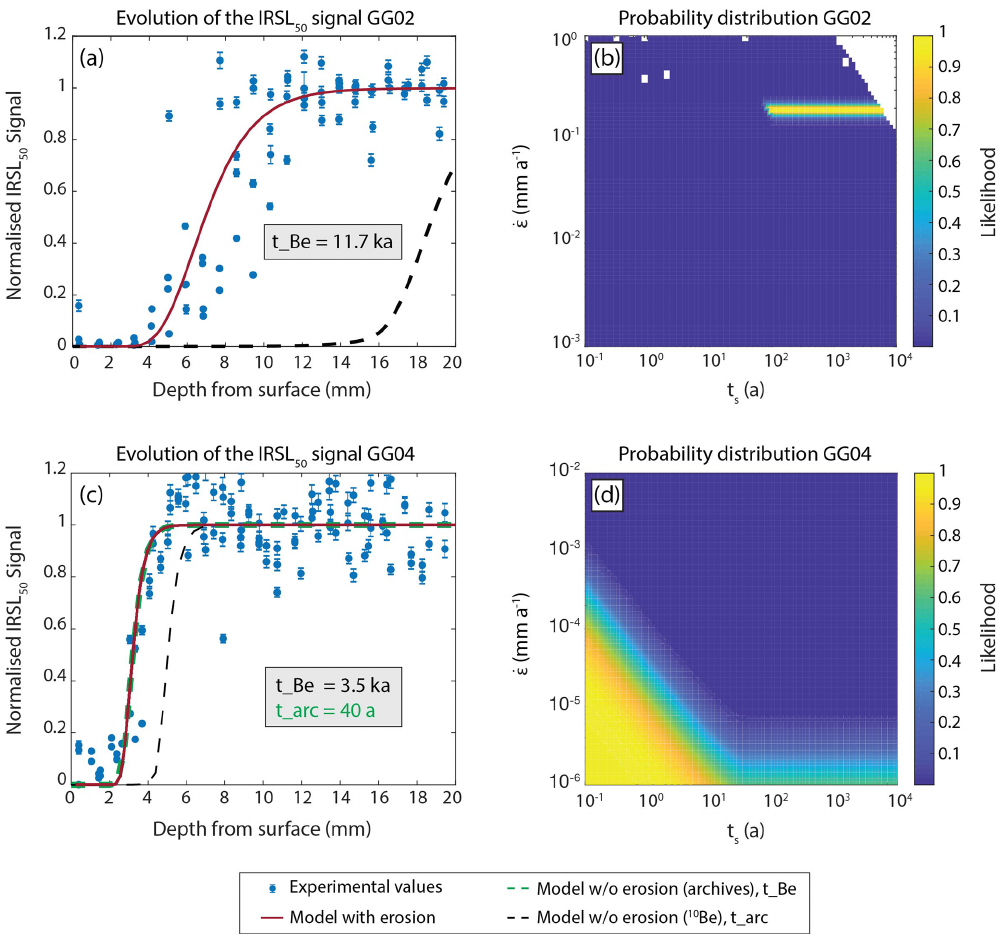
Figure 4. IRSL 50 luminescence–depth profiles and probability distribution inversion results for samples GG02 (a, b) and GG04 (c, d) . For the luminescence profiles (a, c) , the blue dots represent IRSL 50 luminescence measurements at that particular depth. Measurement errors are derived from the square root of the luminescence counts. The dashed black line represents the reference profile expected when using the 10 Be exposure age, uncorrected for erosion, and the red lines are the inverted solutions using the erosion model and the values of ˙ ε and t deemed most likely to fit the data (likelihood > 0.95). The luminescence–depth profile for GG04 (c) also includes a reference profile (dashed green line) when using an exposure age informed from archives of old geological maps and aerial photos. This profile is overlain by the other profiles generated using the erosion model, confirming the information gleaned from the corresponding probability distribution plot that this surface has experienced very low erosion rates. The probability distributions highlight the difference between a sample in steady (b) or transient (d) state with erosion. In panel (b) , the white zone represents the pairs of ˙ ε and t s which cannot predict the 10 Be concentration of sample